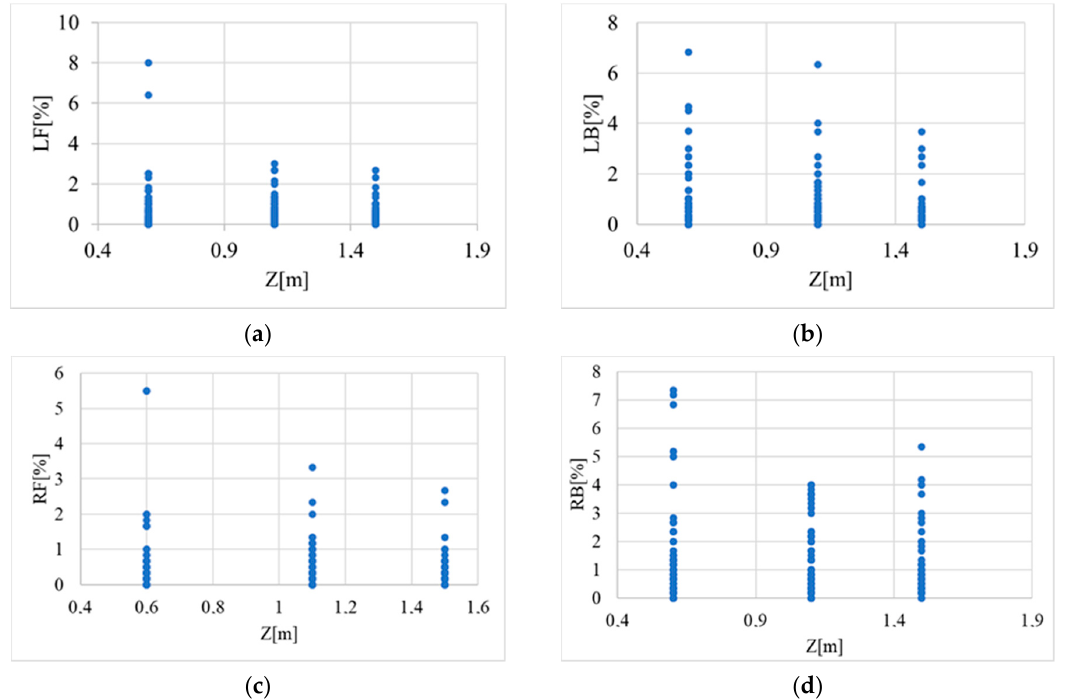
Figure 15. Relations between the number of lost data packets from Anchors: ( a ) LF, ( b ) RF, ( c ) LB, ( d ) RB, and the Z tag coordinate.